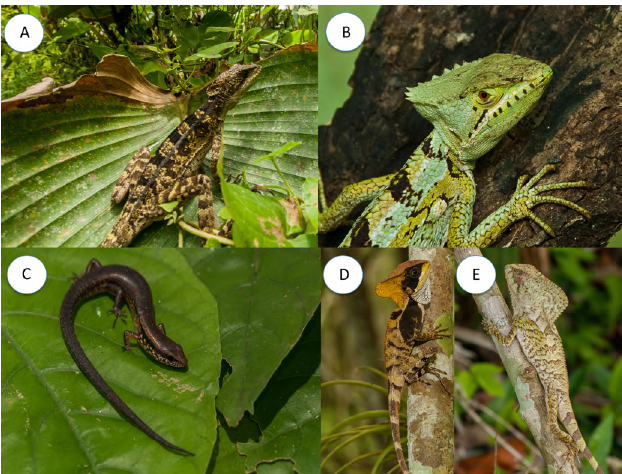
Figure 6. Lizards encountered in the Calakmul Biosphere Reserve: ( A ) Basiliscus vittatus , ( B ) Laemanctus serratus, ( C ) Sphenomorphus cherriei, ( D ) Corytophanes hernandezii , ( E ) Corytophanes cristatus. Photos by TJC.